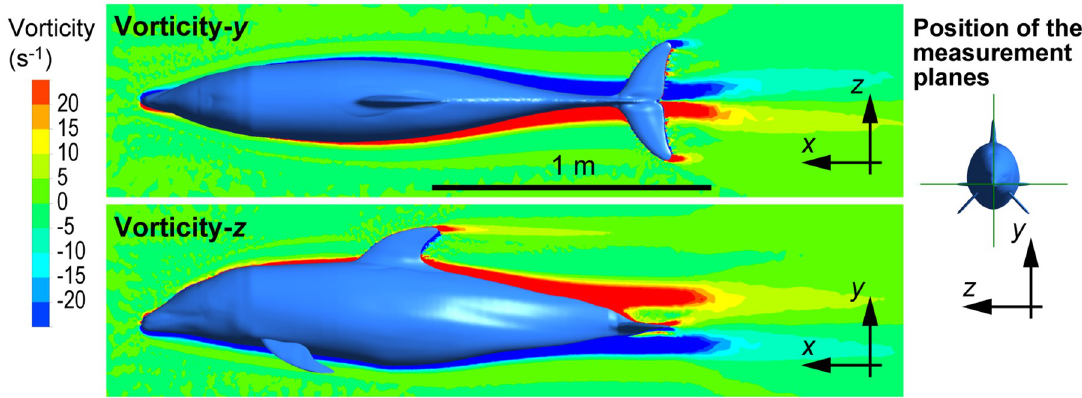
Fig 9. Vorticity about the y -axis on the horizontal plane (upper) and vorticity about the z -axis on the vertical plane (lower) around the model of white-beaked dolphin ( Re = 2 × 10 7 , U = 10.2 m s -1 ).